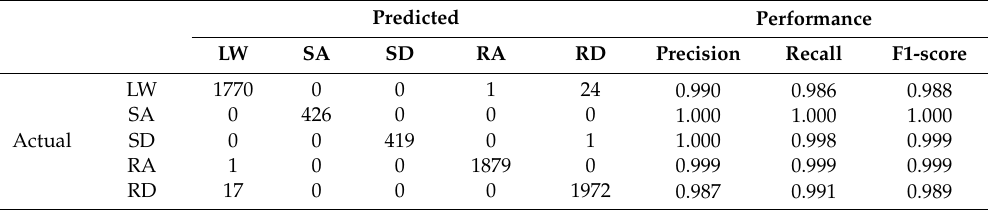
Figure 24. Normalized terrain slope and elevation results in feature space. The maximum values of θ N and h N were used for normalization. The samples of RA and RD for different slopes are colored differently (light gray: ramp 1, medium gray: ramp 2, dark gray: ramp 3). Table 6. Confusion matrix and classification performance of the results using SVM.